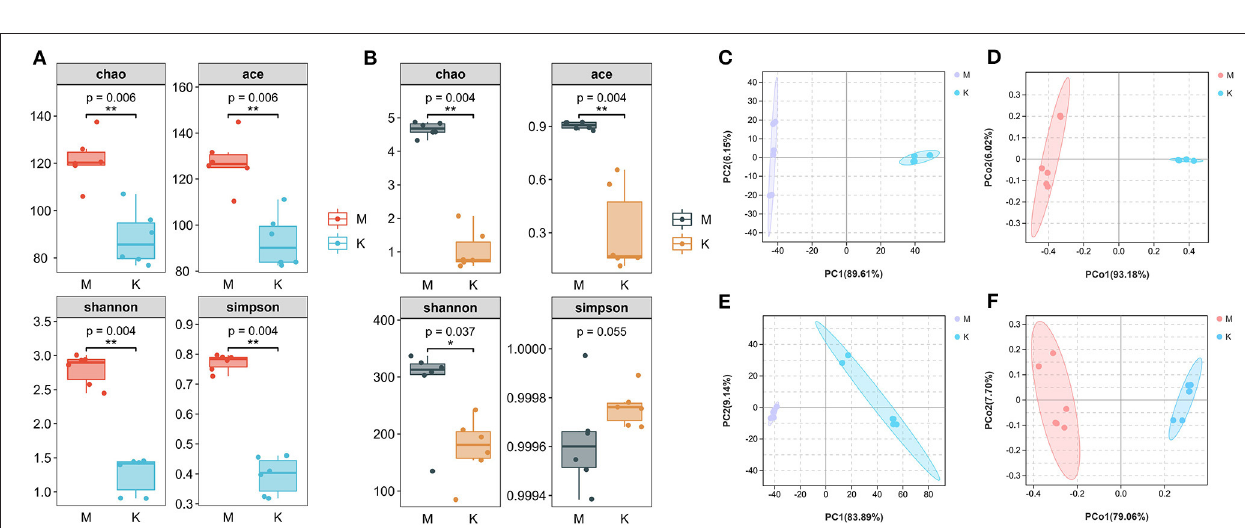
FIGURE 2 | Microbial species abundance and diversity indices of koumiss and mare’s milk. (A) According to the difference analysis of bacterial α diversity, there were differences in the species diversity between the two groups (** P < 0.01). (B) According to the difference analysis of fungal α diversity, there were differences in the species diversity between the two groups (* P < 0.05; ** P < 0.01). (C,D) PCA analysis of bacteria and PCoA analysis with weighted uniFrac distance algorithm. (E,F) PCA analysis of fungal and PCoA analysis with weighted uniFrac distance algorithm.